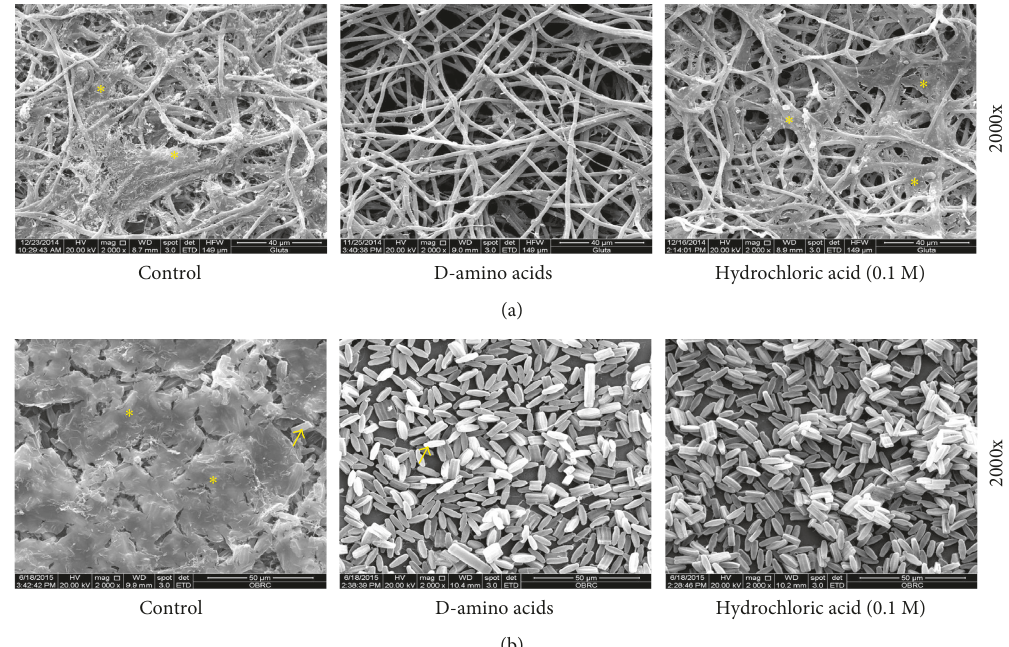
Figure 3: Scanning electron microscopy revealed the presence of biofilms inside DUWLs (a) and reservoir bottle of DCUs (b) after incubation with distilled water, D-amino acids mixture (10 mM each), or 0.1M hydrochloric acid (dissolvent control) for 5 days and subsequently flushed with distilled water. Bacterial biofilm on top of the underlying structure was eliminated in the D-amino acid groups. ∗ Bacterial biofilm. Arrow indicates surface texture of water reservoir